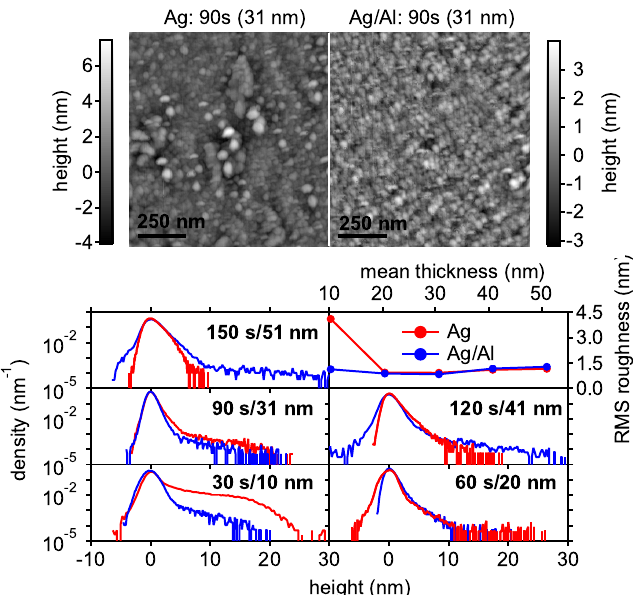
Figure 5. The height distribution for non-seeded Ag (red) and seeded Ag (blue) films as measured by AFM within a region of 5 µ m × 5 µ m. The top right figure displays the RMS average roughness as function of the mean film thickness. The images (top) are AFM height profiles within a 1 µ m × 1 µ m region for non-seeded and seeded layers with a mean film thickness of 31